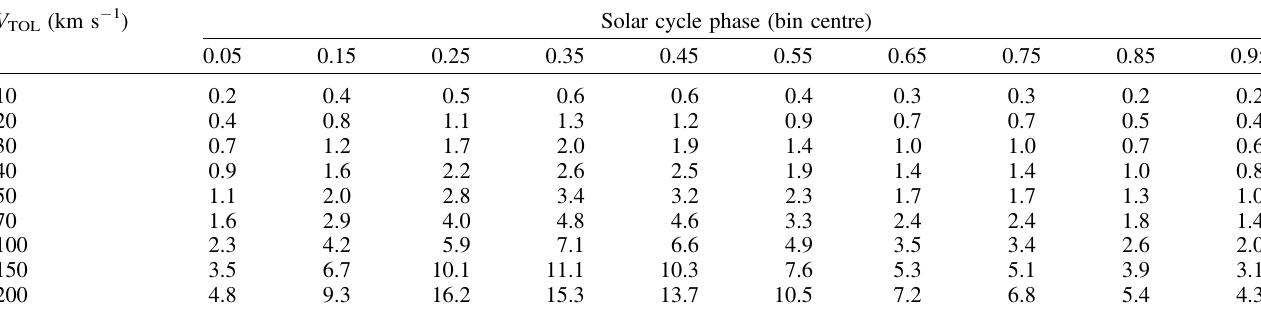
Table 4. k for solar wind near the in-ecliptic plane (averaged over ±7 (cid:1) ), in degrees, as a function of solar cycle phase and V TOL . V TOL (km s (cid:3) 1 )